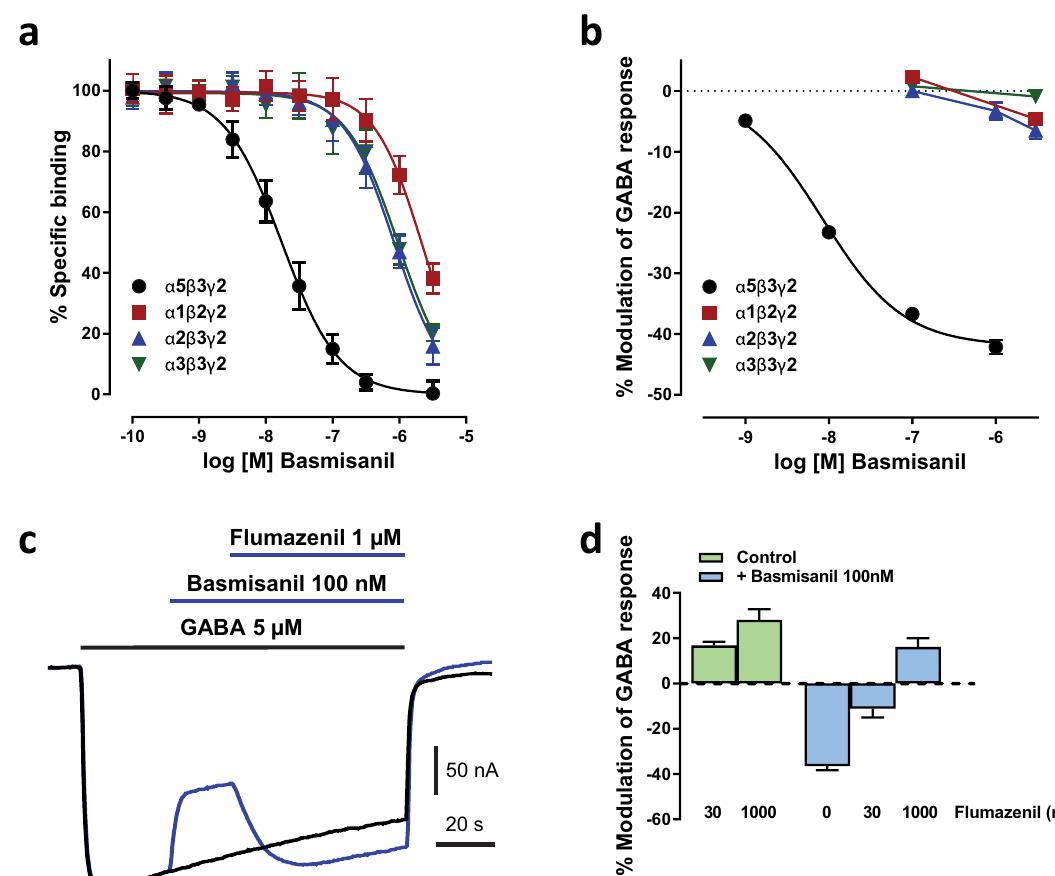
Figure 2. Basmisanil is a potent and highly selective GABA A -α5 receptor NAM. Data in the graphs are shown as mean (symbols) ± SEM (error bars). Error bars smaller than the symbol size are not shown. ( a ) Concentration–response curves of basmisanil in [ 3 H]-flumazenil competition-binding assays to membranes expressing different human recombinant GABA A receptor subtypes (n = 7–9 per concentration). ( b ) Concentration–response curves of the effects of basmisanil on ion current induced by an EC 10 of GABA in Xenopus oocytes (n = 7–8 per concentration). ( c,d ) Flumazenil antagonism of basmisanil effects. ( c ) Example recording of ion current from a voltage-clamped Xenopus oocyte expressing human GABA A -α5. Two current traces are superimposed. The control response (black) was evoked by a GABA application in the absence of any modulators, as indicated by the black horizontal bar. During the test response (blue), after a delay, basmisanil and then flumazenil (blue horizontal bars) were added to GABA. ( d ) Bar graph showing flumazenil antagonism of the basmisanil effect. Green bars: flumazenil alone (30 nM: n = 5, 1000 nM: n = 11). Blue bars: flumazenil in presence of basmisanil (100 nM basmisanil: n = 16; basmisanil + flumazenil 30 nM: n = 6; basmisanil + flumazenil 1000 nM: n =